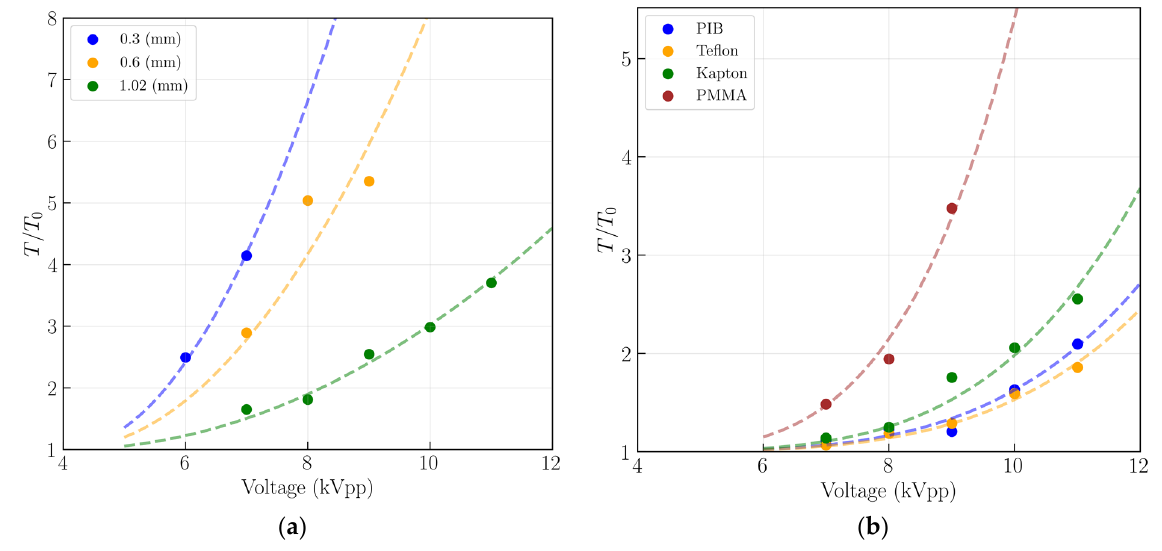
Figure 8. Plasma-induced flow–maximum temperatures achieved operating at different voltage levels and a frequency of 24 kHz for the actuators made of ( a ) Kapton with different dielectric thicknesses; ( b ) different dielectric materials with a thickness of 1 mm.